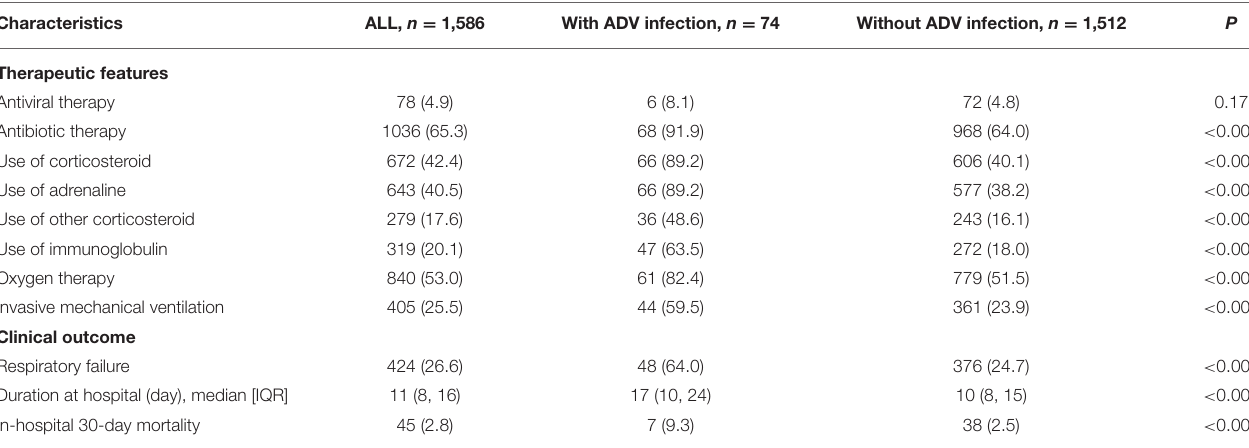
TABLE 3 | Therapeutic and clinical outcome of 1,586 children with severe pneumonia with and without ADV